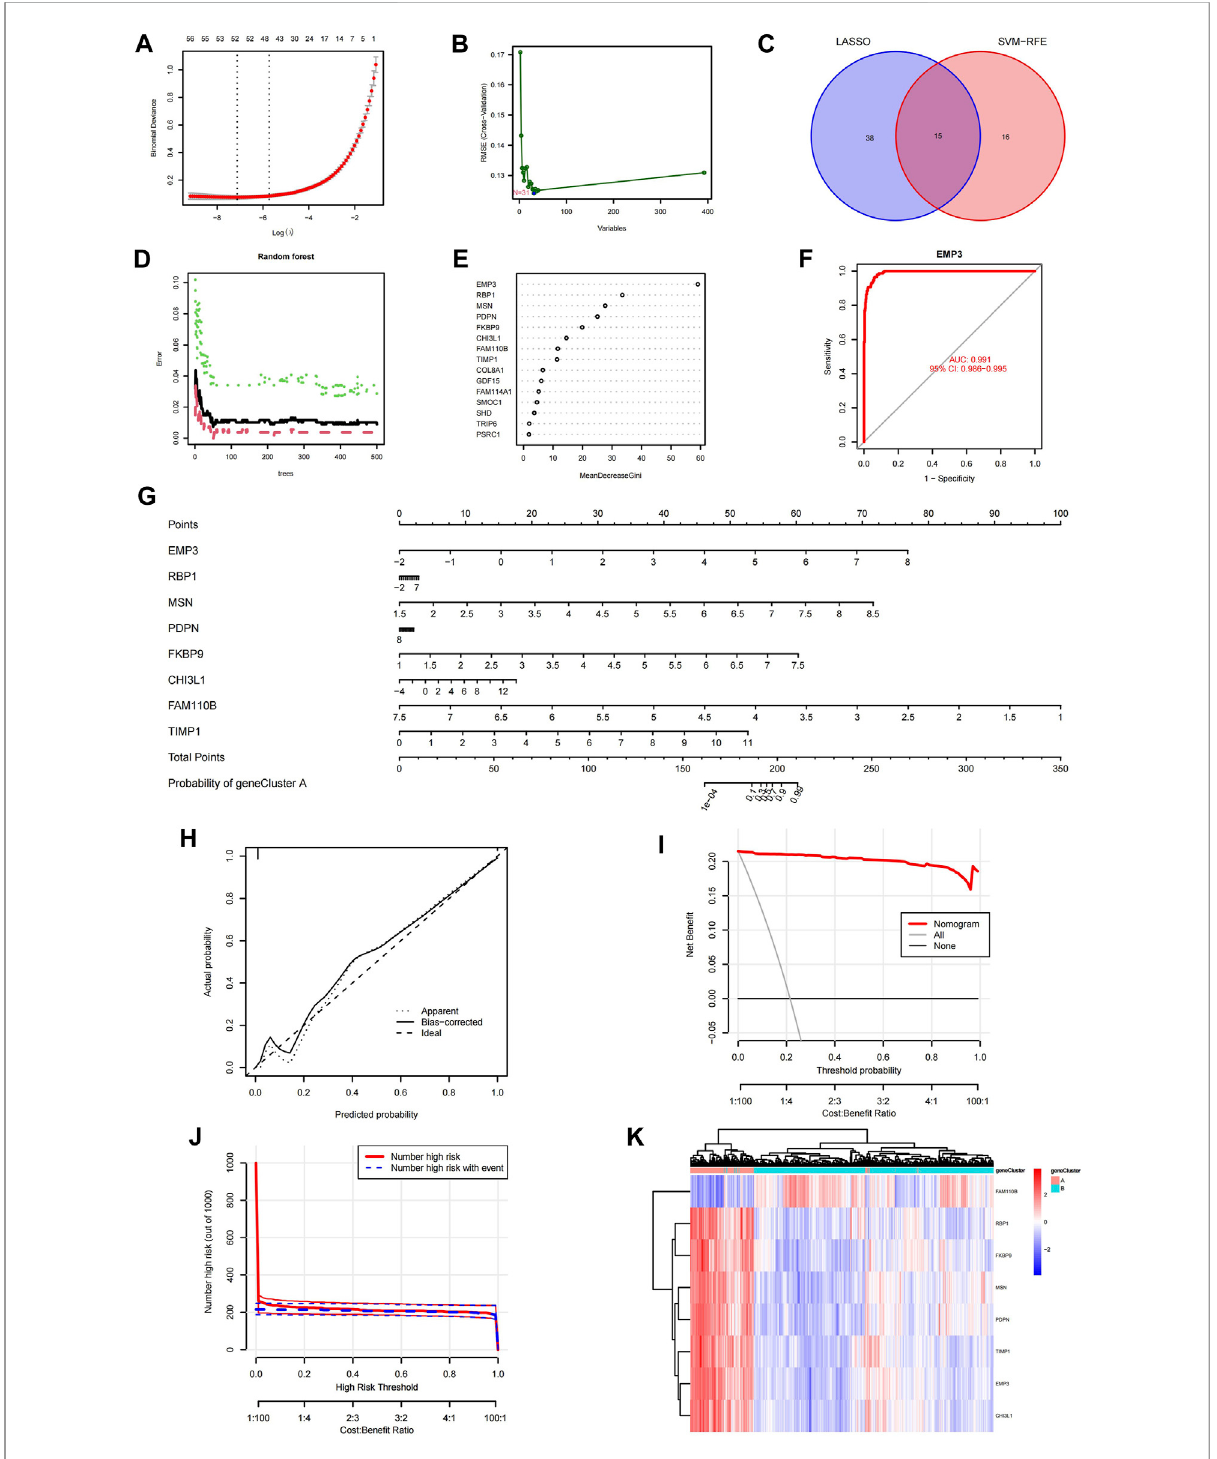
FIGURE 3 Identi fi cationofthefeaturedACAFRGsfordiscriminatingagingCAF-relatedgeneclusters. (A) Determinationoftheoptimalnumberoffeatured ACAFRGs by LASSO logistic regression, in which 53 featured ACAFRGs were determined when the lambda value was minimal. (B) Determination of the optimal number of featured ACAFRGs by using the SVM-RFE algorithm ( N = 31). (C) Venn plot showing the 15 overlapped featured ACAFRGs obtained by the aforementioned methods. (D) Optimal number of the random forest trees was determined when the cross-validation error presented minimal. The red dots represent the samples in gene cluster A, the green dots represent the samples in gene cluster B, and the black dots representallthesamples. (E) ImportanceofthefeaturedgenesinwhicheightACAFRGswithimportancehigherthan10wereselectedastheoptimal